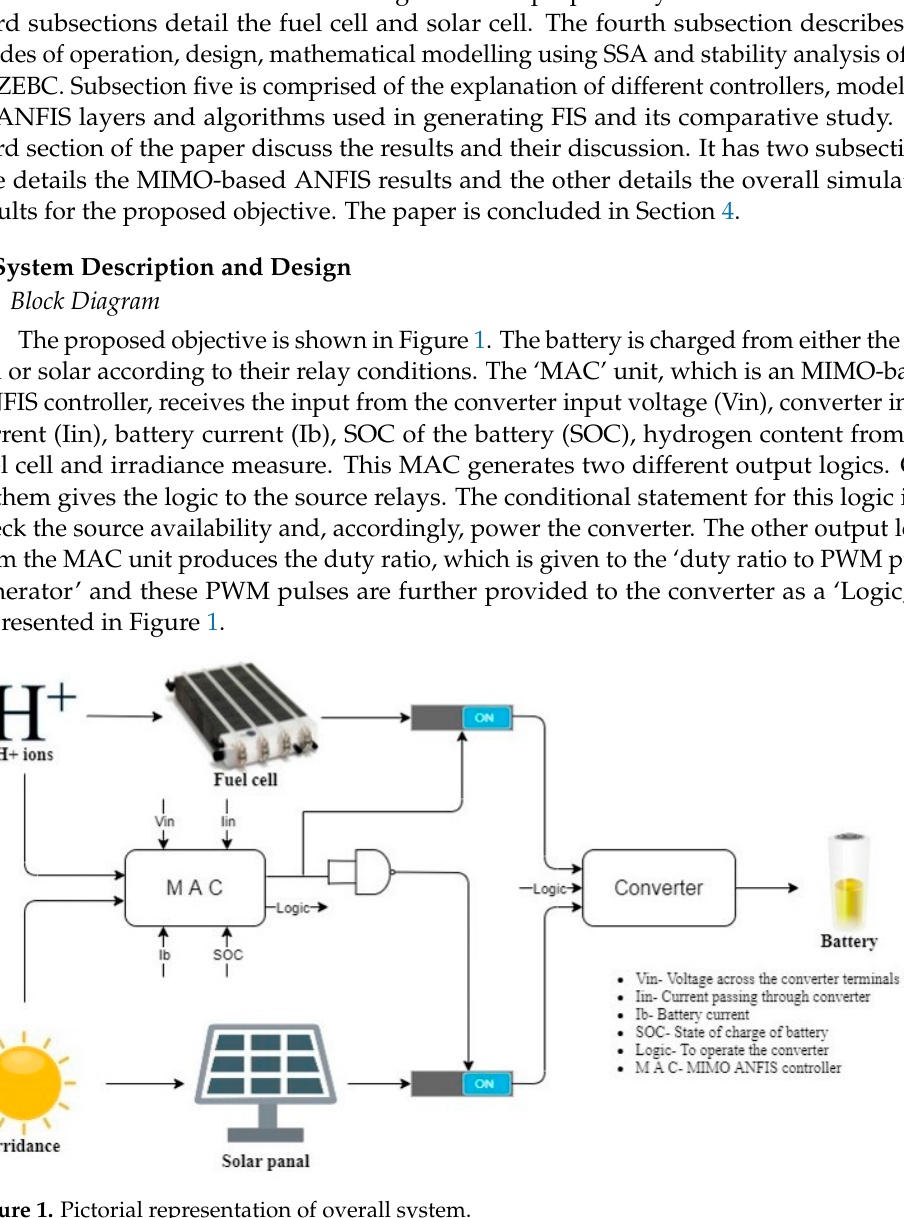
Figure 1. Pictorial representation of overall